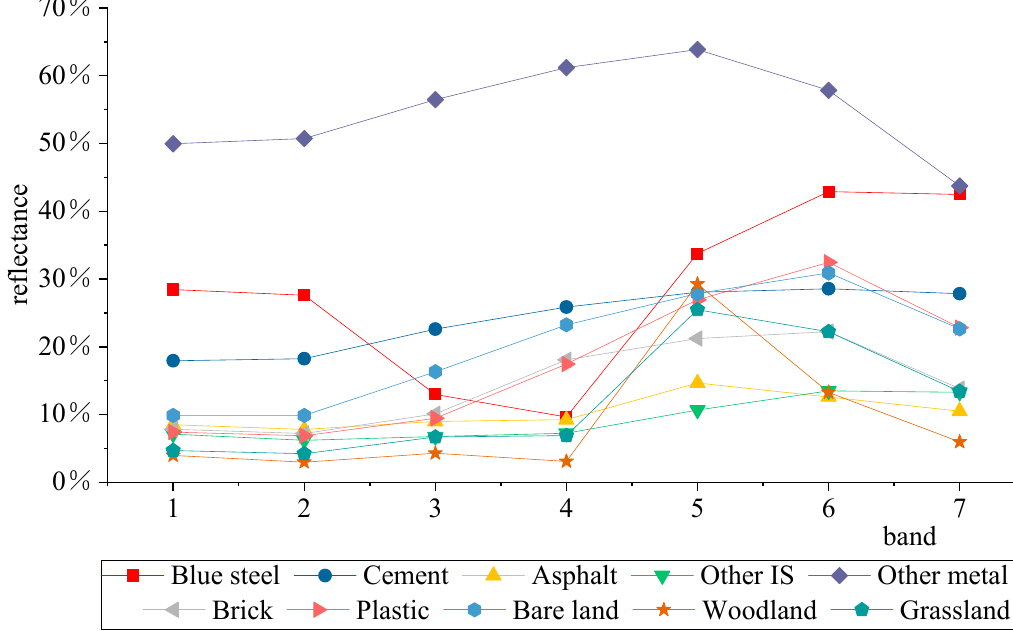
Figure 6. Spectral endmembers curves (Other IS: other impervious surface).